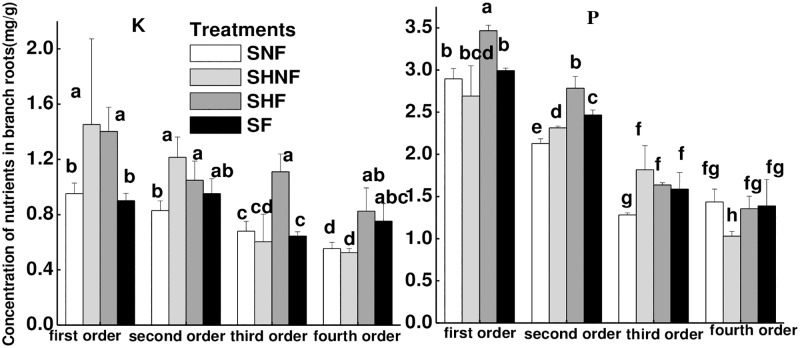
The concentrations of K and P in roots of different branch order affected by nutrients heterogeneity.Noted: SHNF is the non-fertilizer compartment in SHF treatment; SHF is the fertilizer compartment in SHF treatment. Different letters indicate significant treatment effects between the means at p<0.05 analyzed by post hoc Tukey’s HSD test (means ± SE, n = 8).